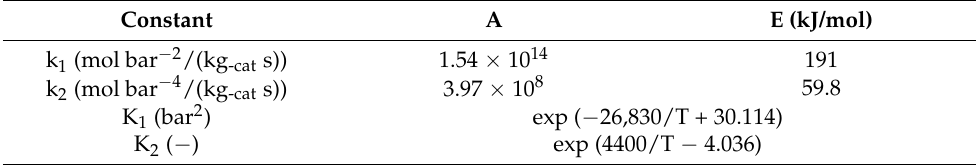
Figure 8. Comparison of the experimental reaction rates and calculated reaction rates. Table 2. Arrhenius parameter values for reforming and water–gas shift reactions.